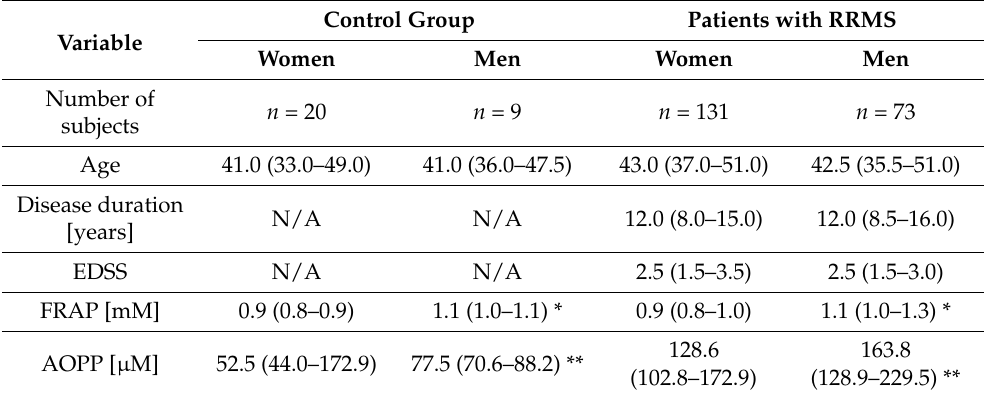
Table 2. Characteristics of group of patients with RRSM and the control group divided according to gender.